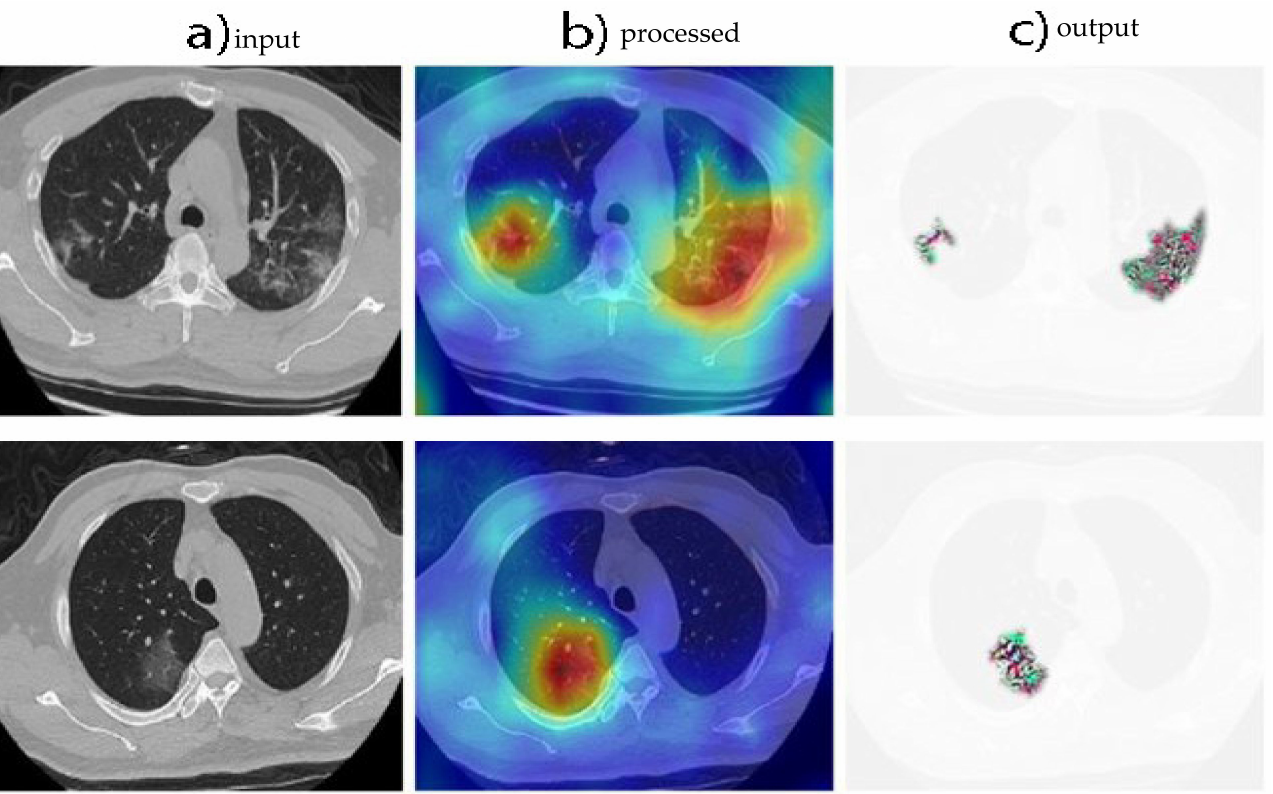
Figure 6. Grad-CAM visualization of model predictions on CT